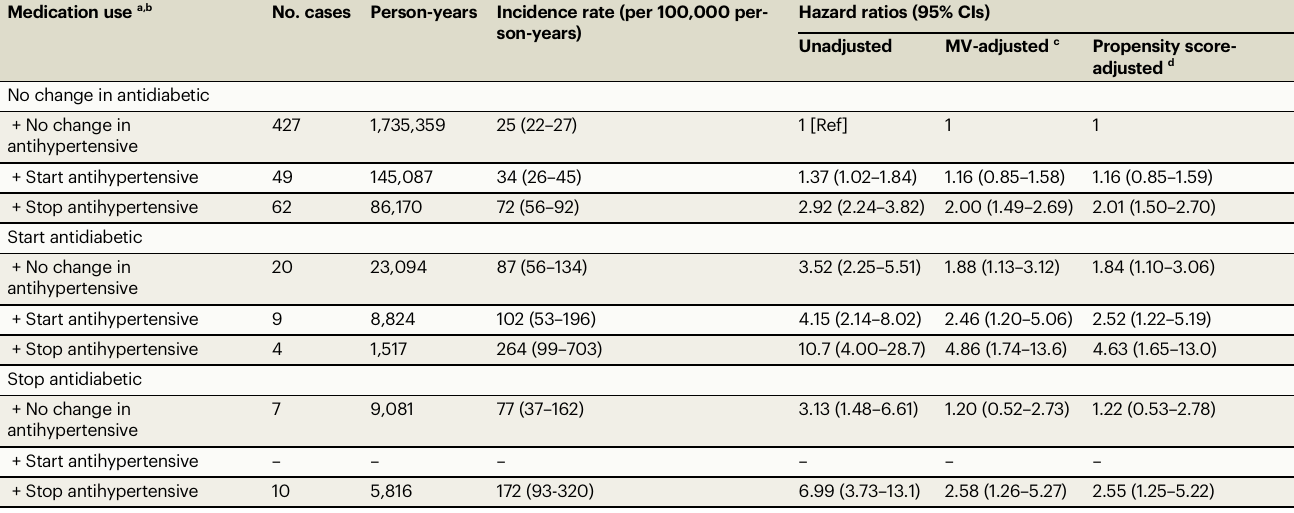
Table 2 | Combined associations of recent changes in antidiabetic and antihypertensive medication use with 2-year risk of pancreatic cancer diagnosis Medication use